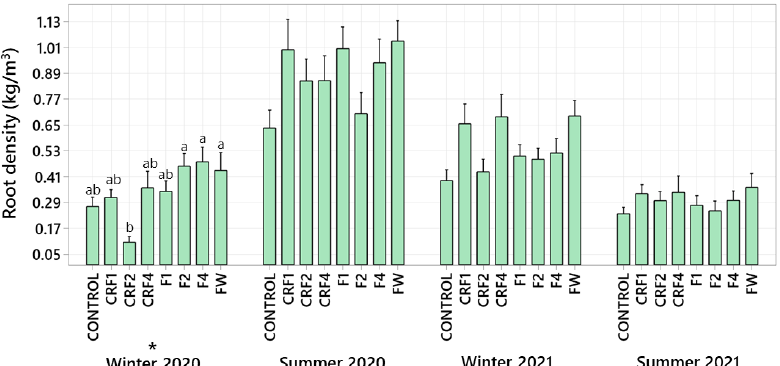
Figure 2. Root density (kg/m 3 ) measured from Winter 2020 to Summer 2021. Six-year-old HLB-affected ‘Ruby Red’ grapefruit trees grafted on sour orange rootstock were used. A one-way analysis of variance (ANOVA) with a Tukey honestly significant difference (HSD) test was used to determine significant differences between means. Letters indicate statistically significant differences ( p ≤ 0.05). Bars represents standard error. Asterisks (*) indicate differences between the means of all granular treatments vs. all liquid treatments determined using a linear contrast analysis.